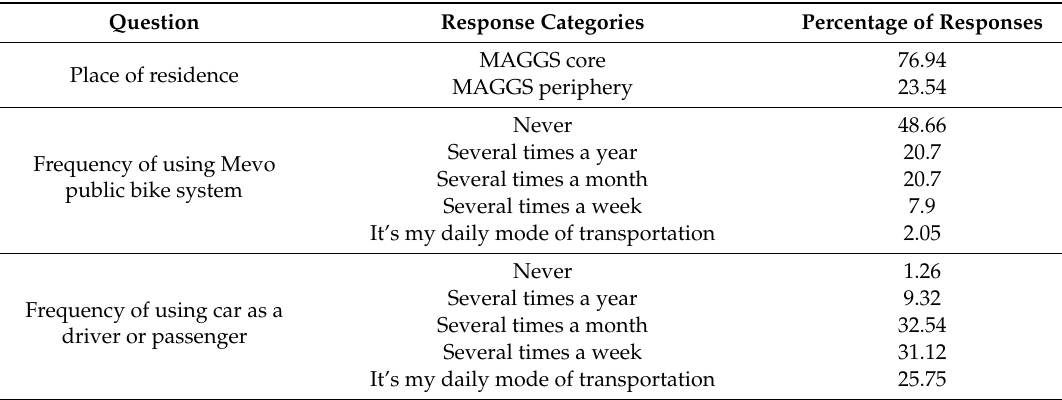
Table 2. Questions used in the correspondence analysis and the structure of the